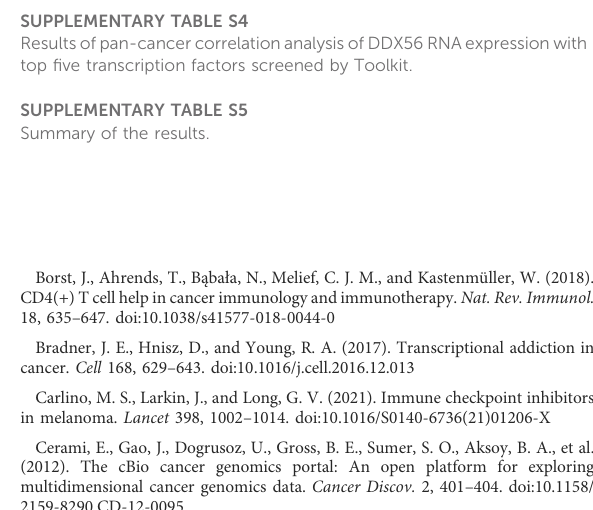
List of CRISPR screening studies showing that DDX56 is associated with the proliferation of cancer cells.